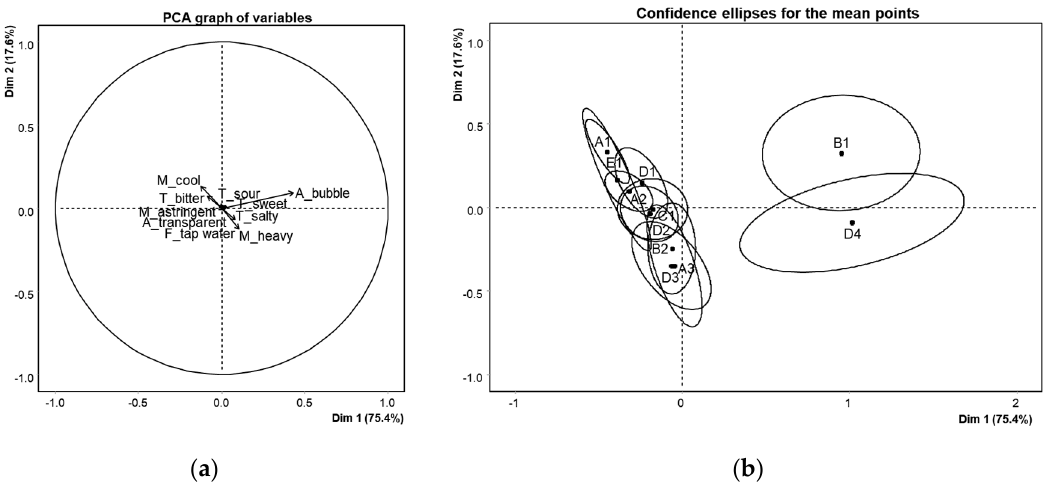
Figure 1. ( a ) Principal component analysis (PCA) of descriptive analysis (DA); ( b ) confidence ellipses of sample configurations of DA.